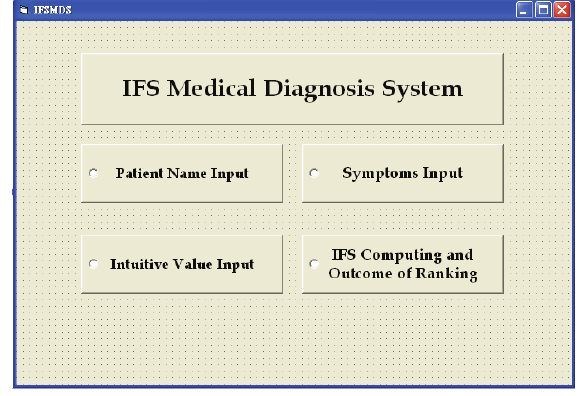
Fig. 5. The functional interface of the